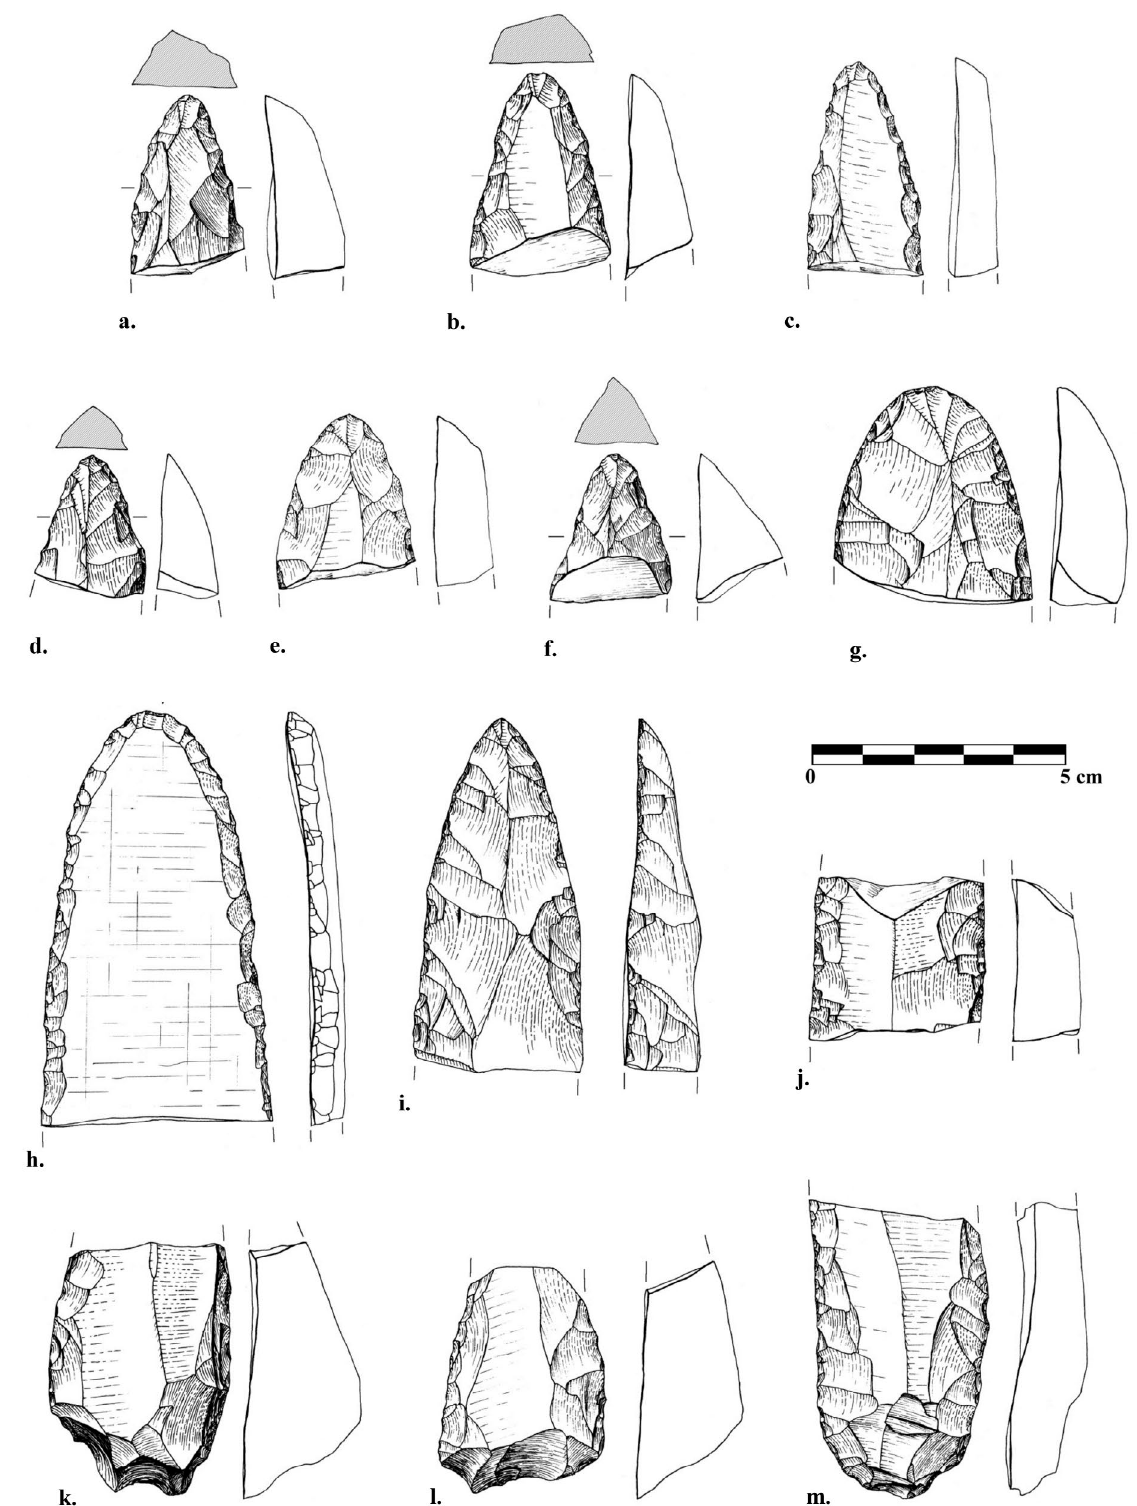
Figure 6. Fragments de pièces façonnées unifacialement. a-g : fragments apicaux, h-i : fragments mésio-apicaux, j : fragment mésial, k-m : fragments mésio-basaux. Figure 6. Unifacially shaped artefact fragments. a-g: apical fragments, h-i: mesio-apical fragments, j: mesial fragment, k-m: mesio-basal